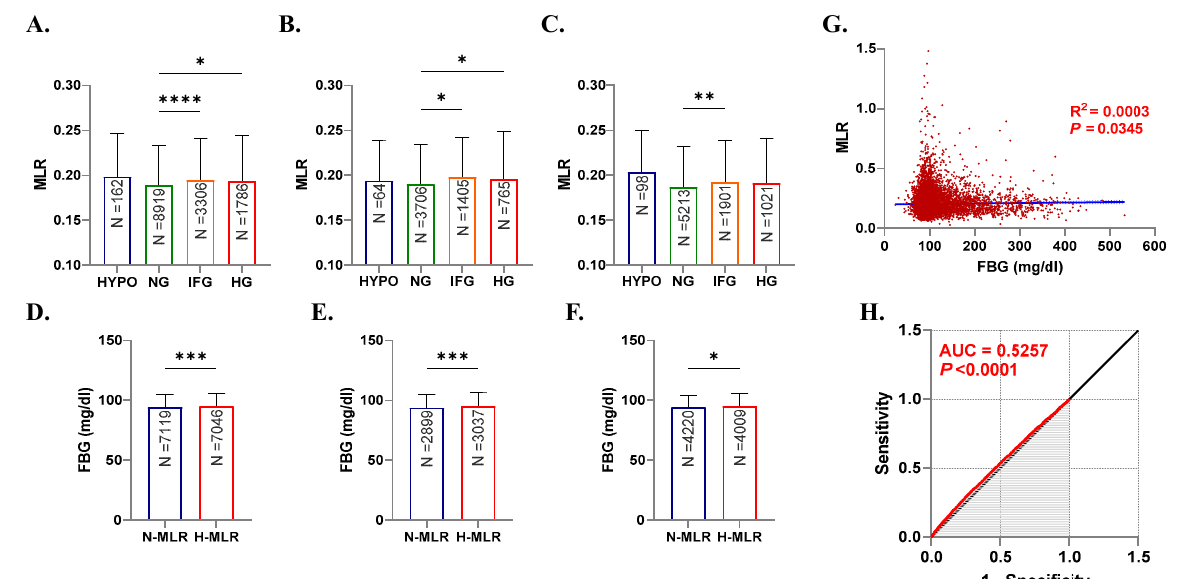
Figure 2. Patterns of MLR in light of FBG levels. Medians + IQR of MLR in both genders ( A ), males ( B ), and females ( C ), and of FBG in both genders ( D ), males ( E ), and females ( F ). Spearman’s correlation ( G ) and ROC curve ( H ) of MLR and FBG. ns indicates not significant, while * p < 0.05, ** p < 0.01, *** p < 0.001, and **** p < 0.0001.